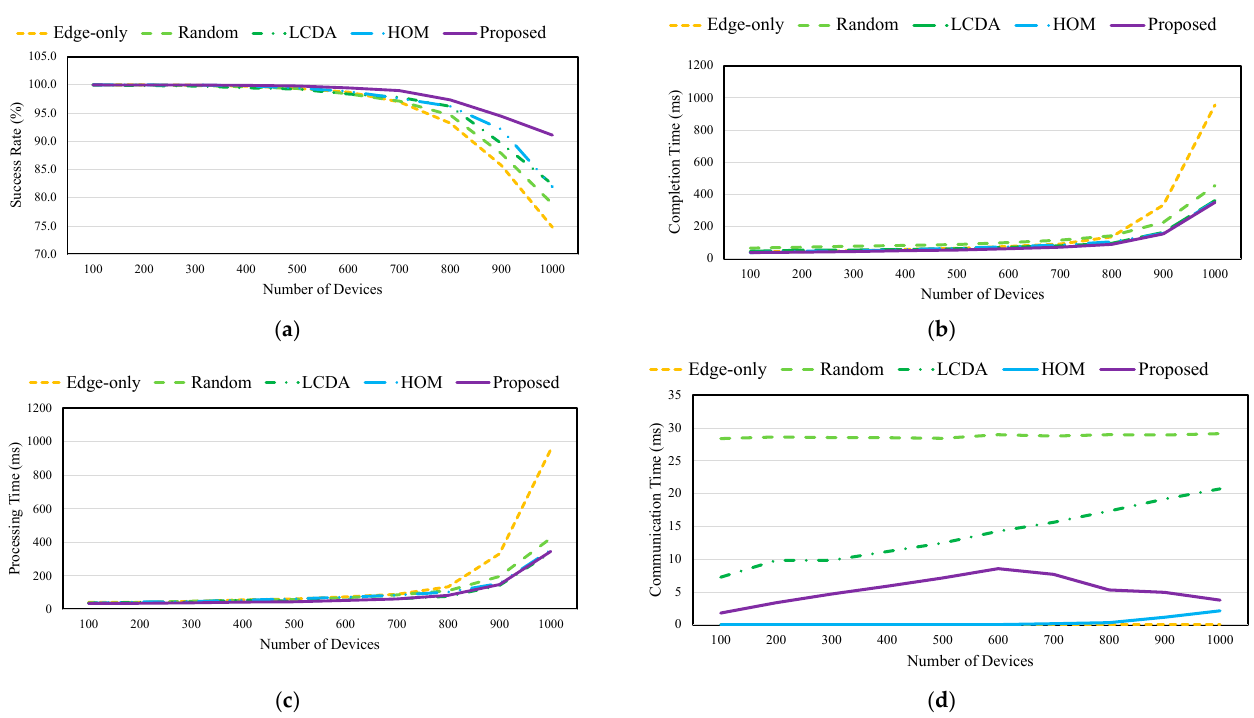
Figure 6. QoE of collaboration schemes for various tasks: ( a ) Success rate; ( b ) Completion time; ( c ) Processing time; ( d ) Communication time.